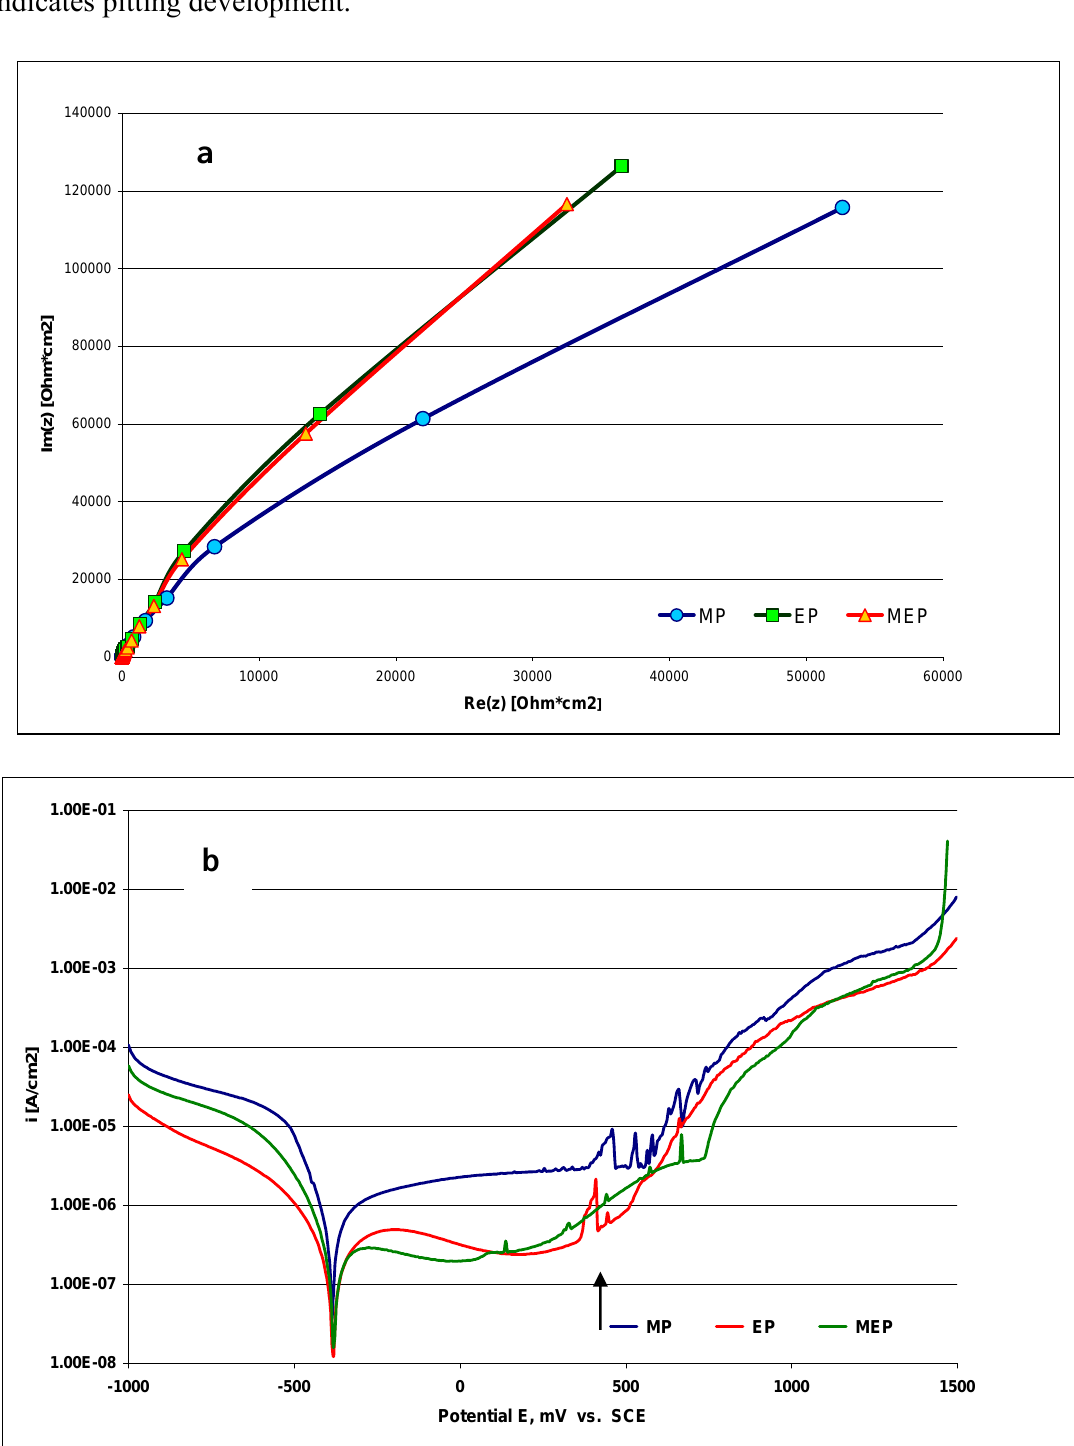
Figure 4. Electrochemical Impedance Spectroscopy results (Nyquist plots) of AISI 316L SS (a), and (b) polarization curves obtained on AISI 316L SS sample surface in Ringer’s solution; both after three types of treatments MP, EP, MEP. The arrow in Figure 4b indicates pitting